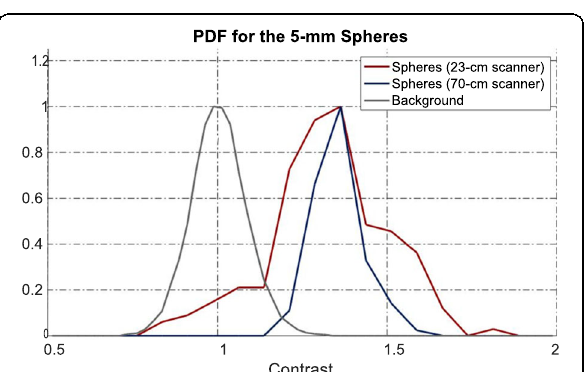
Fig. 3 (abstract A20). Probability distribution functions for the 5-mm lesions on the 23-cm scanner (red) and the 70-cm scanner (blue), along with the background PDF (grey), depicting less overlap between the signal and background PDFs for the 70-cm scanner compared to the 23-cm scanner and implying better lesion detectability. PDFs will be used to calculate lesion detectability using the